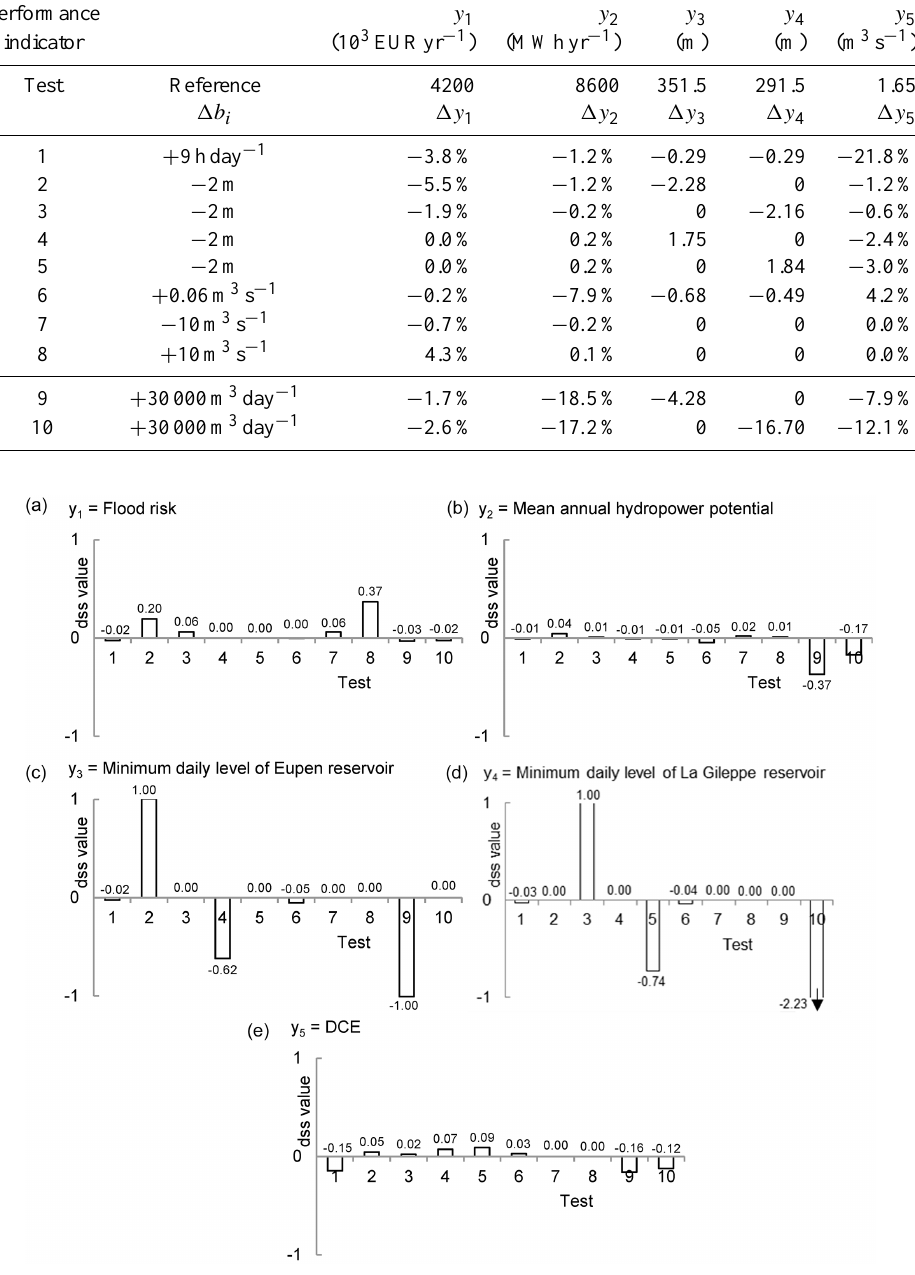
Table 7. Variations of operating rule parameters (b i ) and their incidences on indicators (y j ) .